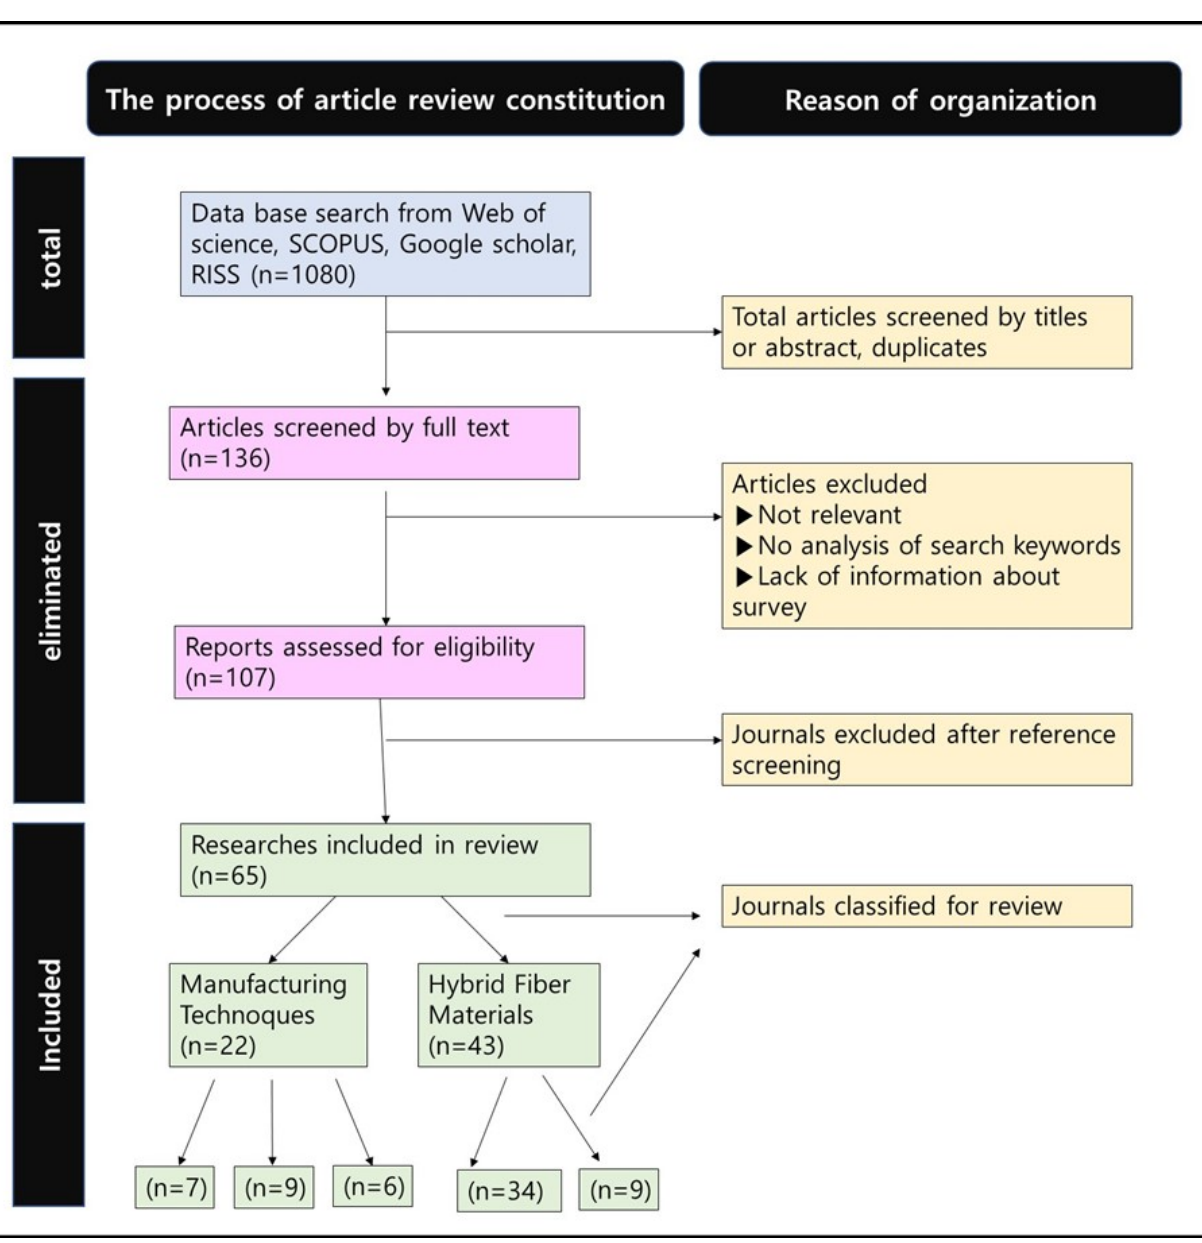
Figure 1. The identification process of research via databases.